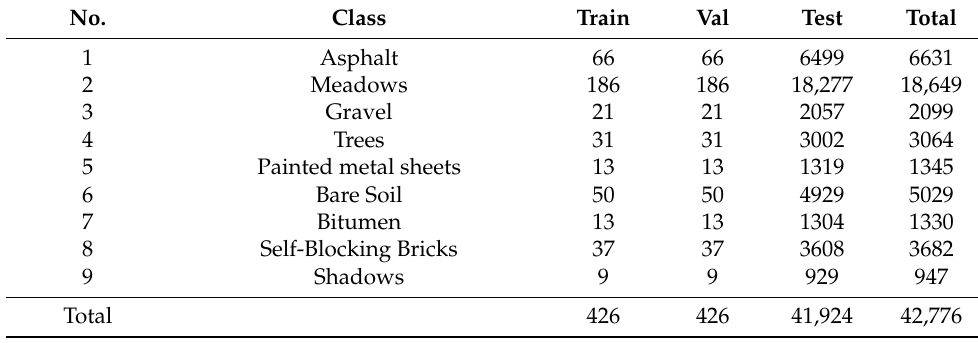
Table 6. Land-cover classes and corresponding numbers of samples in the PU dataset.